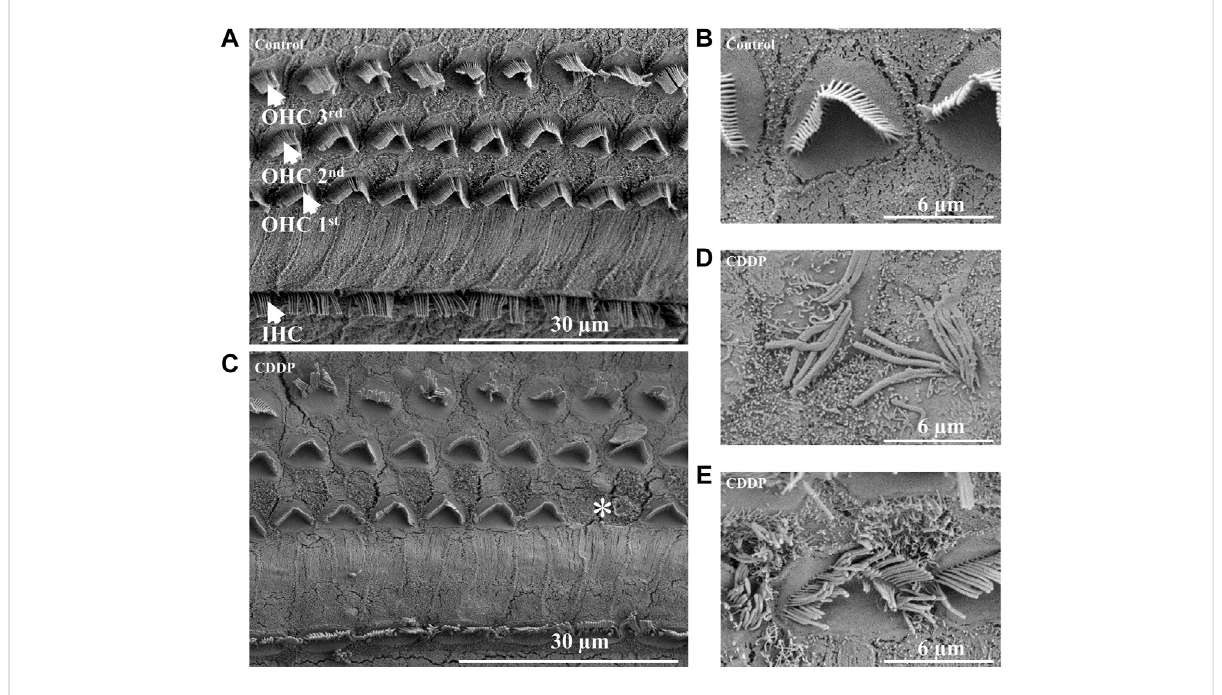
FIGURE 3 Cisplatin causes damage and loss of OHCs. (A) and (B) The IHCs and OHCs in the control group were arranged neatly without cell damage or loss. (C – E) In the CDDP group, loss of OHCs, abnormal arrangement, lodging and fusion of stereocilia were observed. Scale bar, 30 μ m or 6 μ m *represents missing